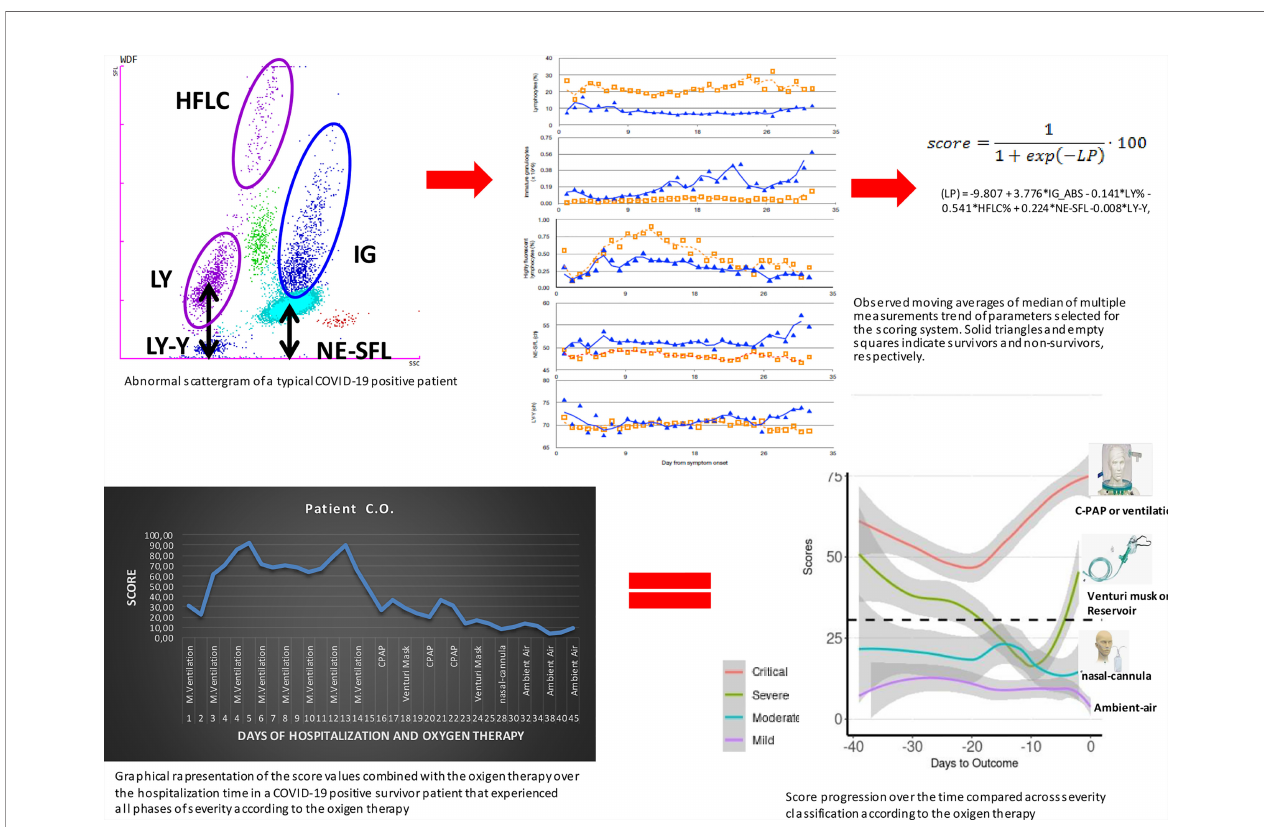
FIGURE 5 | Graphical representation of the entire logical hypothesis of the study starting from the typical abnormal scattergram of a COVID-19-positive patient from which have been selected the 5 predictors of the score. The analysis of data of the fi ve parameters gave the moving averages of median that can clearly show differences between survivors and non-survivors. The accurate statistical analysis provided the fi nal score that has been combined to the severity of patients according to the symptomatic OXY therapy administered. Finally, the combination of all what above described into the graphical representation of a COVID-19 patient over the time of 45 days of hospitalization that went through different phases of the disease severity according to the OXY therapy that show the solid power of the score in representing, preceding, and explaining the course of the disease from the immunological point of